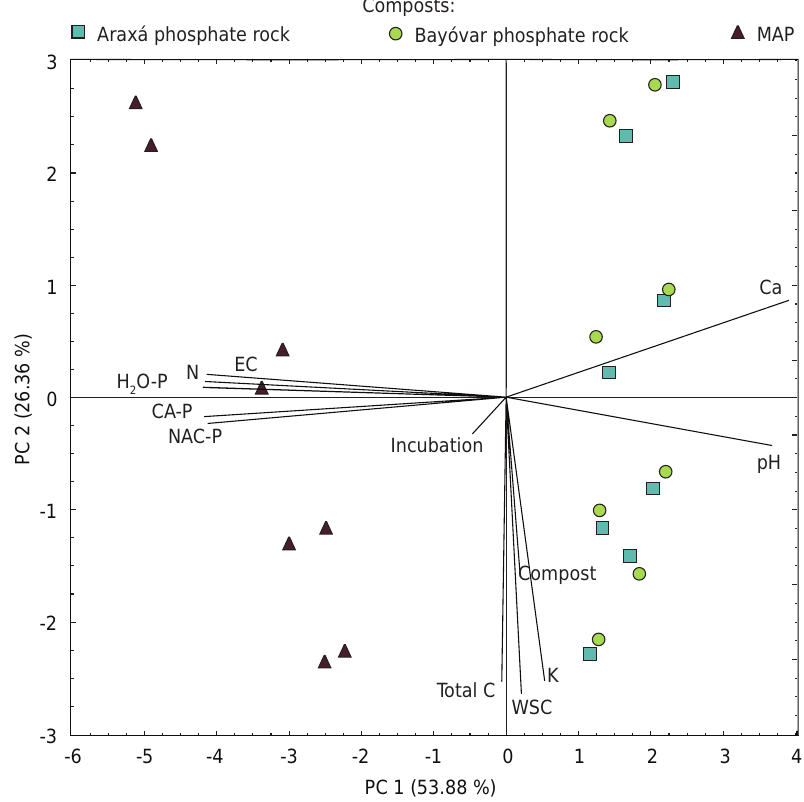
Figure 6. Principal component analysis (PCA) for P source (clustering), type of compost, incubation, and evaluated chemical variables: pH, total contents of Ca, K, N, C, and water-soluble C (WSC); indexes of P soluble in water (H 2 O-P), in citric acid (CA-P), and in neutral ammonium citrate plus water (NAC-P), and electrical conductivity